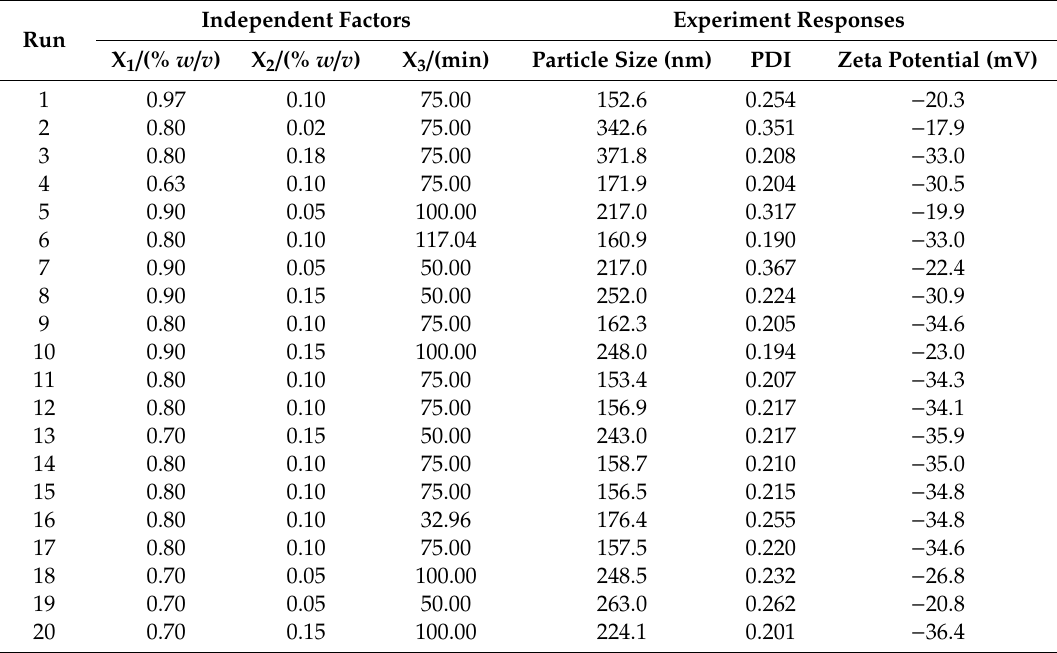
Table 2. Table 2. Observed response for the 20 experimental runs in central composite design. Independent Factors Experiment Responses Run